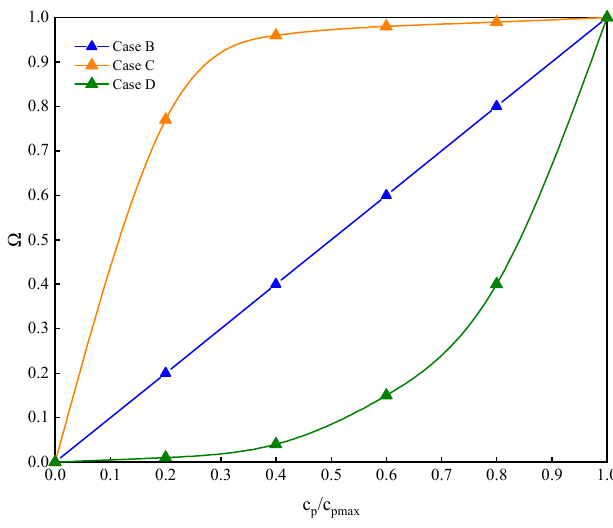
Figure 10. The interpolation factor comparison of the three cases. Table 3. Model setting of the cases study.